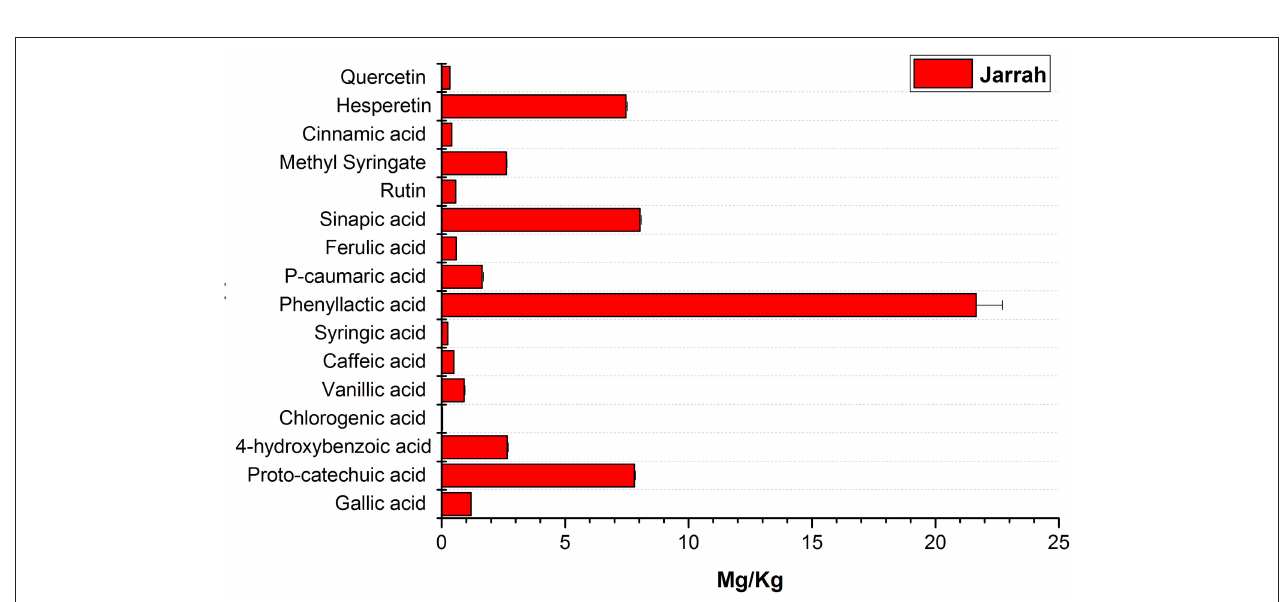
FIGURE 8 | Comparative analysis of phenyllactic acid in honeys.